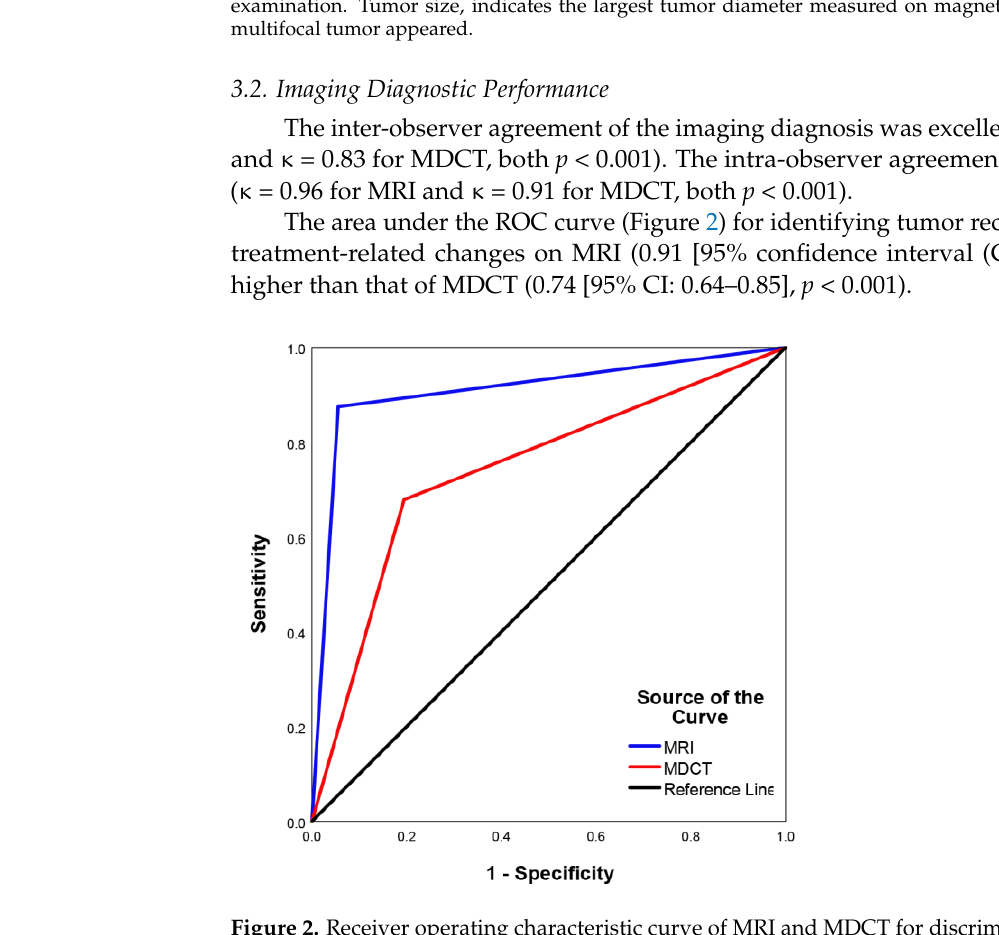
Table 3. Diagnostic performance for recurrent BCs between MRI and MDCT.